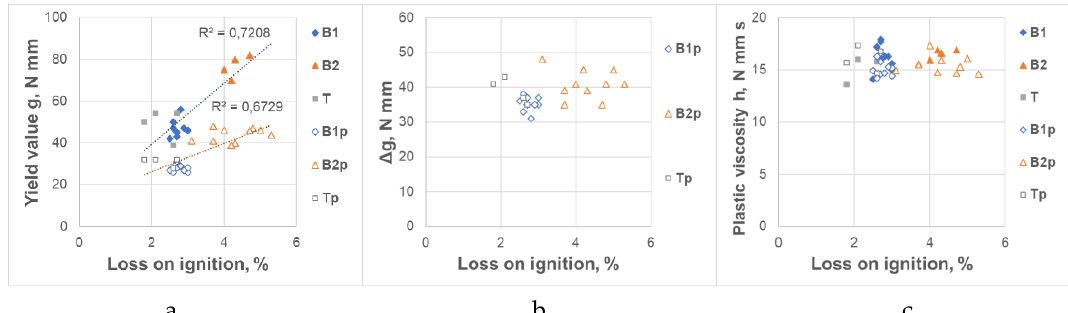
Figure 3. Influence of the loss on ignition of CFA on rheological properties of CFA mortars. ( a ) Yield value g; ( b ) Increase of the yield value g in time ∆ g, ( c ) Plastic viscosity h.